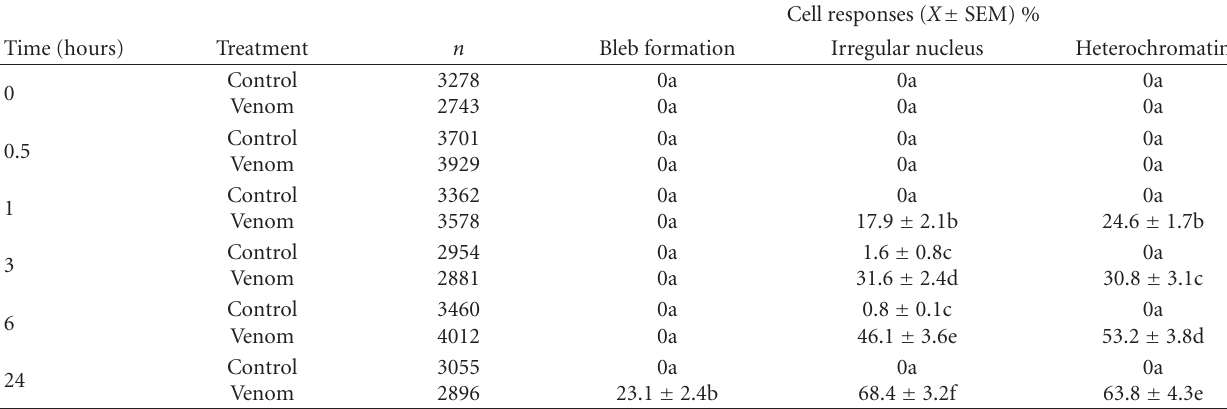
Table 1: Cellular responses of brain tissue from S. bullata to envenomation by N. vitripennis